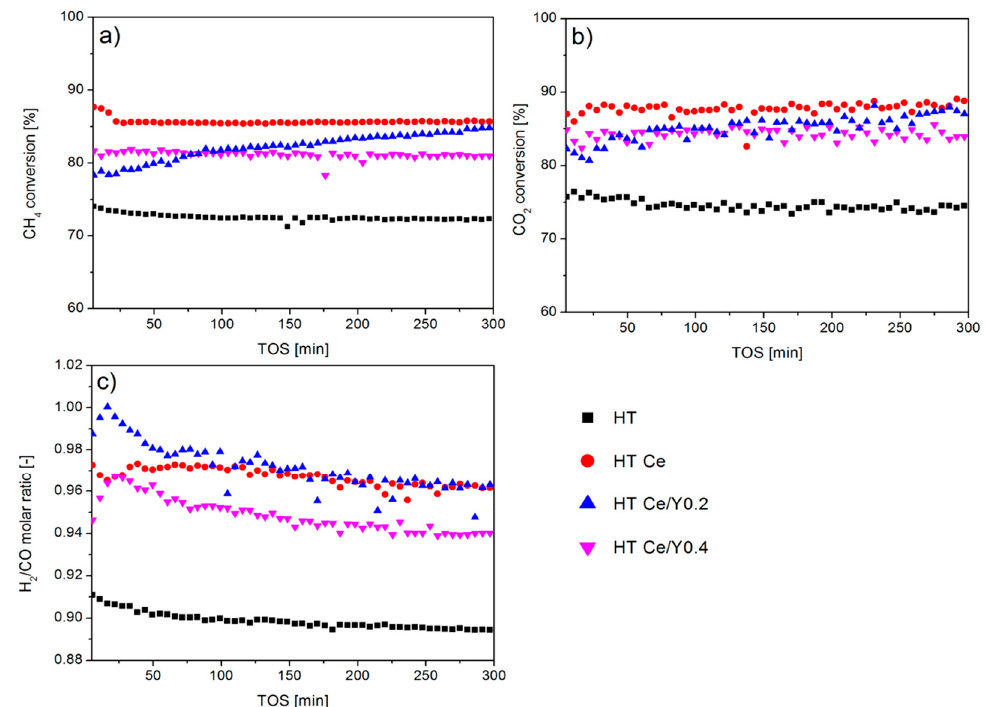
Figure 6. The results of DRM catalytic tests over Ce- and Y-modified catalysts: ( a ) CH 4 conversion, ( b ) CO 2 conversion and ( c ) H 2 /CO molar ratio. Reaction conditions: T= 700 °C, 5 hours, GHSV = 20,000 GHSV = 20,000 h − 1 , CH 4 /CO 2 /Ar = 1/1/8, total flow rate 100 cm 3 h − 1 , CH 4 /CO 2 /Ar = 1/1/8, total flow rate 100 cm 3 /min.